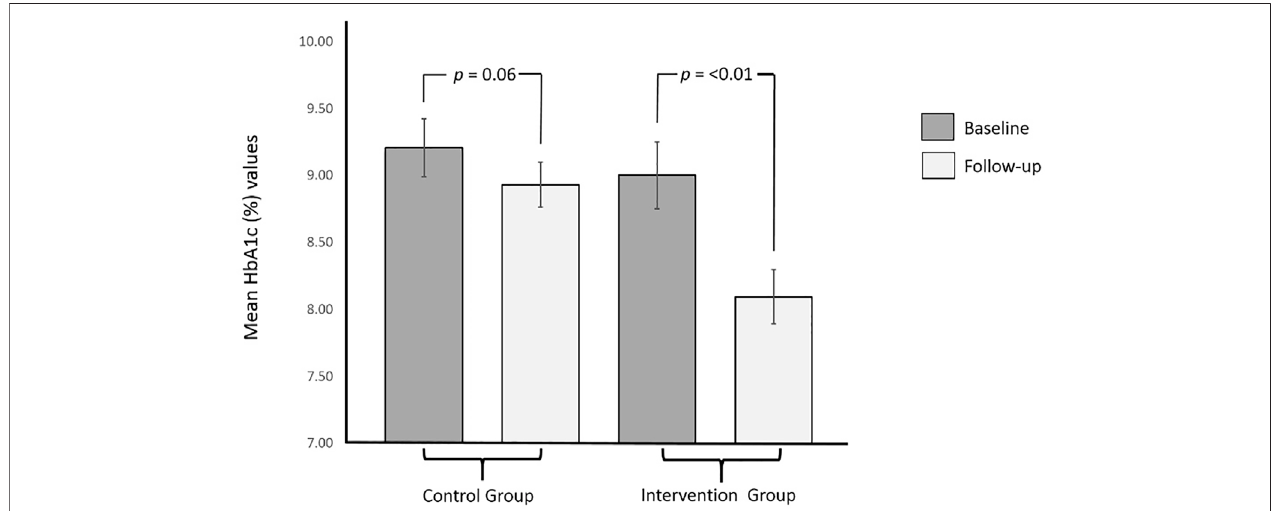
FIGURE 2 | Mean baseline and fi nal (after 6 months) HbA1c values in control and intervention groups.